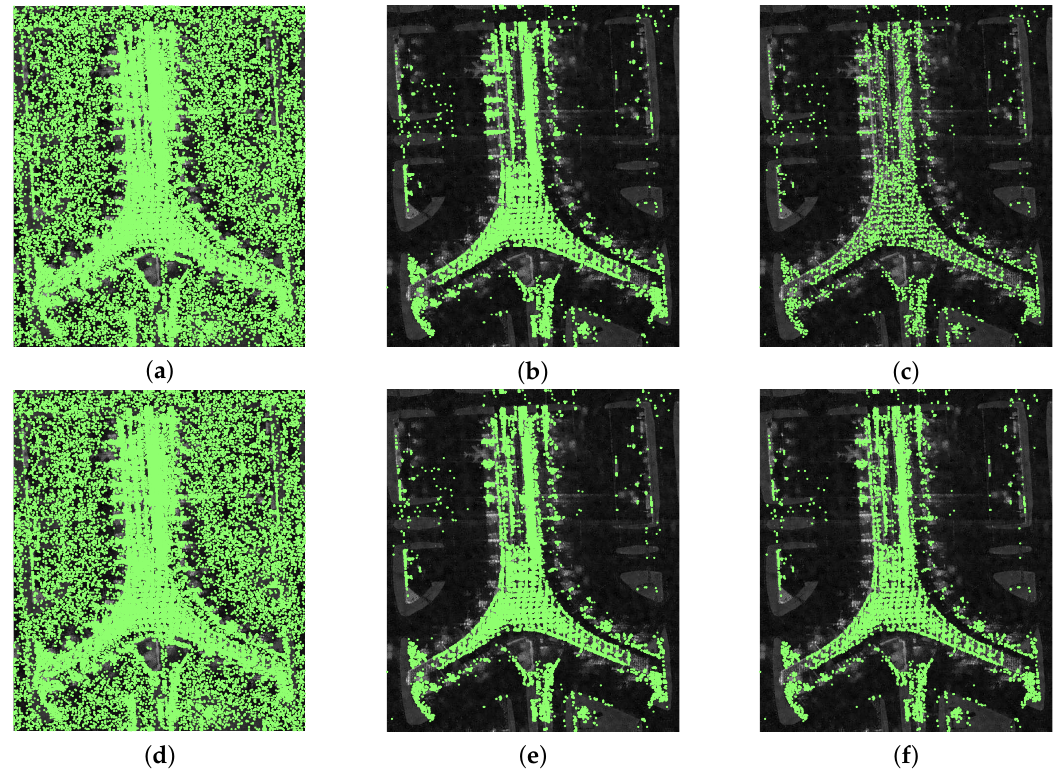
Figure 7. Comparison of PSCs results of StaMPS and IStaMPS (green points on the SAR image represent the PSCs): StaMPS PSCs after ( a ) Step 1, ( b ) Step 2, and ( c ) Step 3; and IStaMPS PSCs after ( d ) Step 1, ( e ) Step 2, and ( f ) Step 3.